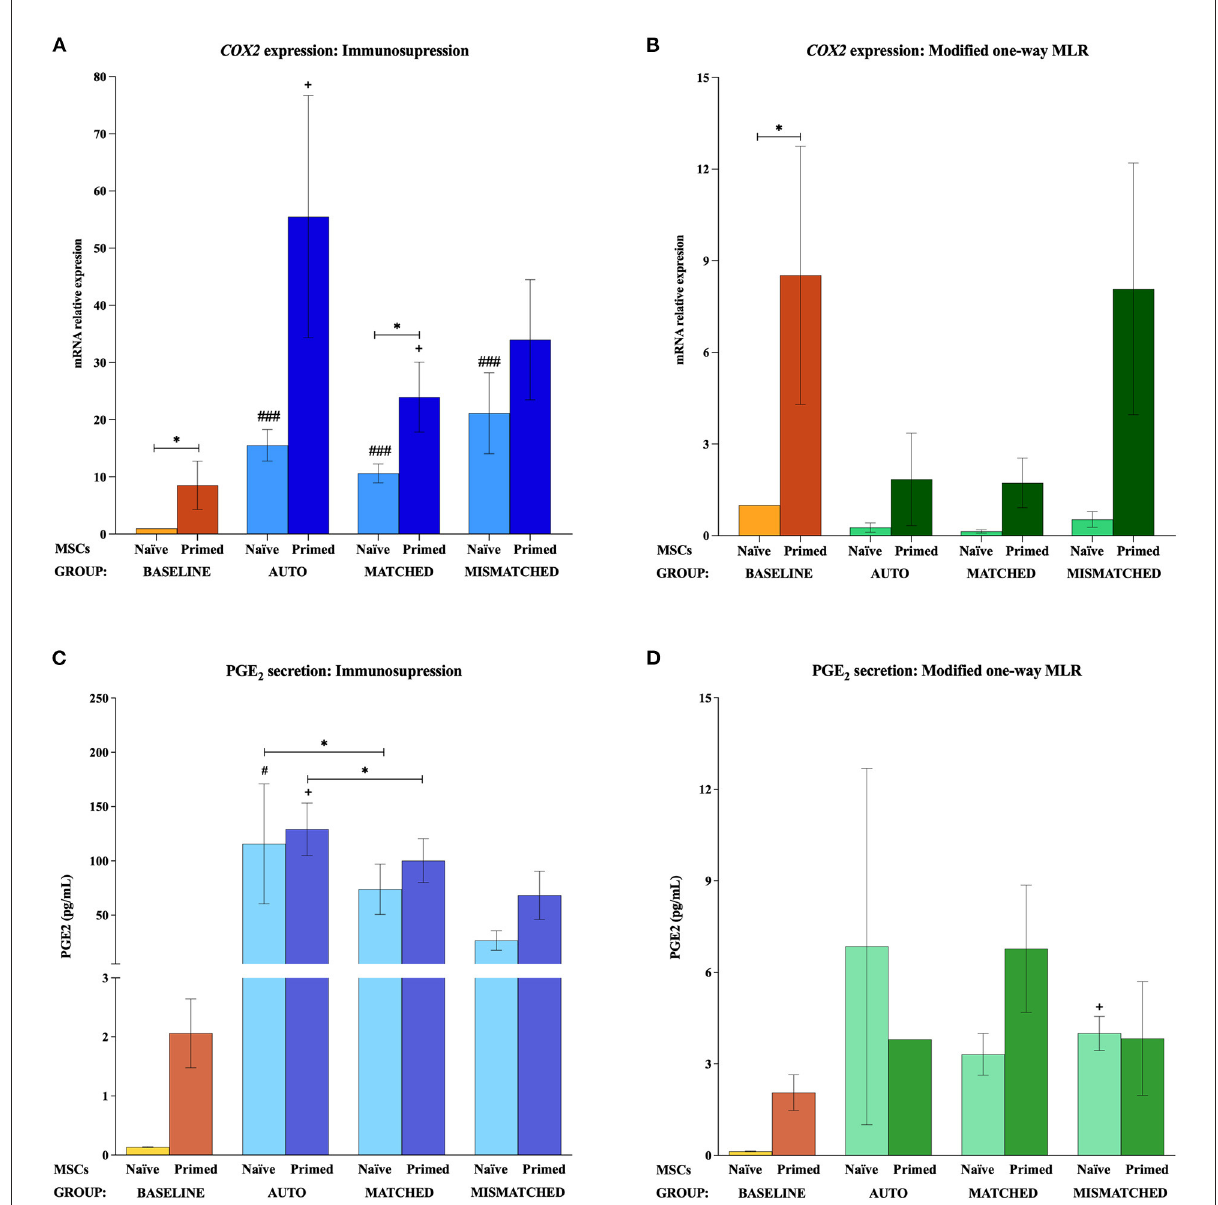
FIGURE3 Cyclooxygenase 2 (COX2) gene expression and prostaglandin E2 (PGE 2 ) secretion by equine mesenchymal stem cells (MSCs) in the different scenarios. (A) COX2 mRNA relative expression and (C) PGE 2 secretion (pg/mL) before (baseline; orange bars) and after equine MSC-naive (light blue bar) and MSC-primed (dark blue bar) were exposed in vitro to phytohemagglutinin (PHA)-activated peripheral blood lymphocytes (PBLs) (immunosuppression assays). (B) COX2 mRNA relative expression and (D) PGE 2 secretion before (baseline; orange bars) and after MSC-naive (light green bar) and MSC-primed (dark green bar) were exposed in vitro to resting PBLs [modified one-way mixed lymphocyte reaction (MLR) assays]. Co-cultures of MSCs and PBLs were autologous ( n = 3) or allogeneic, matched ( n = 8), or mismatched ( n = 7) for the major histocompatibility complex. Changes in gene expression are represented as mean ± S.E.M of the relative mRNA expression, using baseline MSC-naive as reference sample (light orange bar, value 1). Concentration of PGE 2 in the supernatant from the different conditions is represented as mean ± S.E.M (pg/mL). Significant differences of each condition compared with the baseline MSC-naive (light orange bar) are represented by hashes (#) above the corresponding bar ( # p < 0.05; ### p < 0.001). Significant differences compared with the baseline MSC-primed (dark orange bar) are represented by a cross ( + ) above the corresponding bar ( + p < 0.05). Significant differences between experimental conditions are represented by a squared line with an asterisk ( * p <